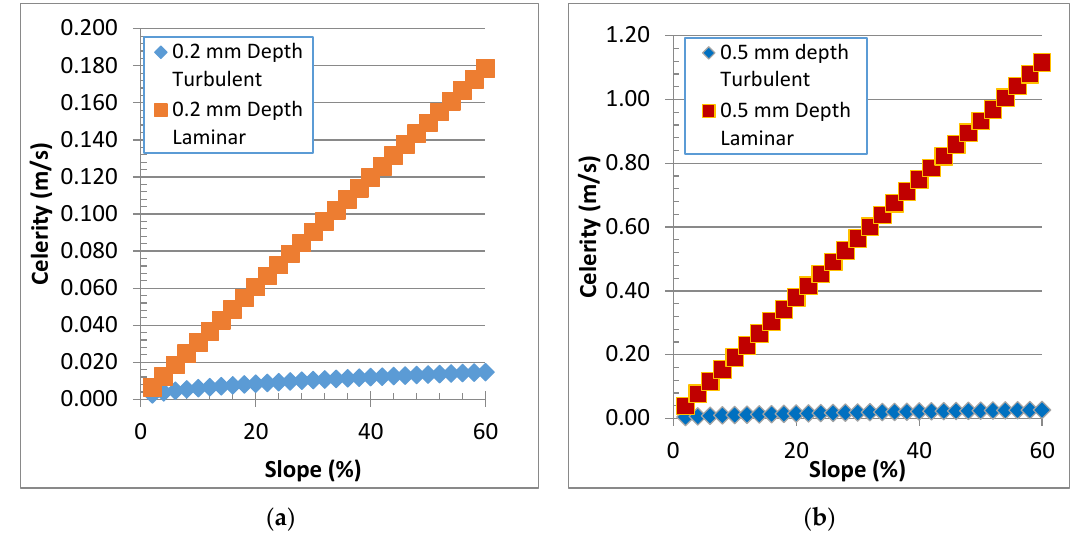
Figure 3. Dependence of the wave celerity on laminar or turbulent flow assumptions for 0.2 mm ( a ) and 0.5 mm ( b ) flow depth and Manning’s n = 0.30.